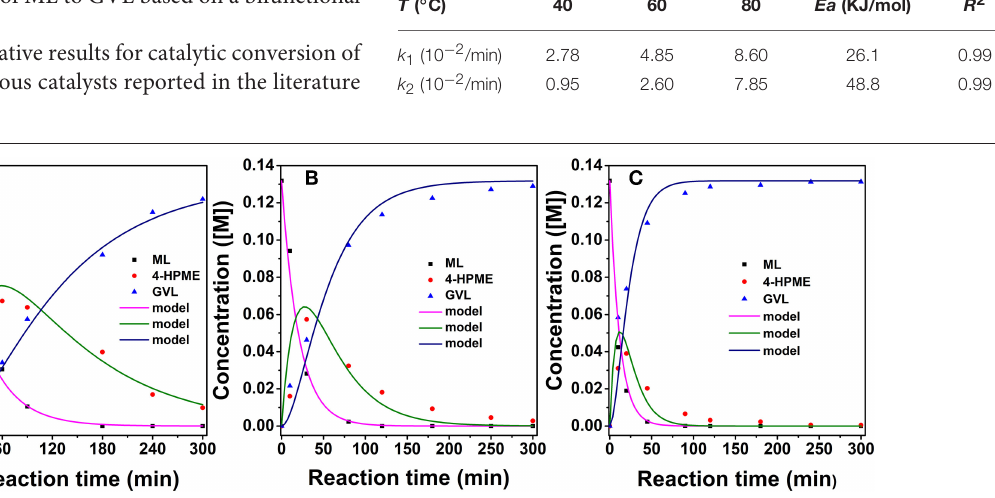
FIGURE 9 | Experimental data fitting at 40 ◦ C (A) , 60 ◦ C (B) , and 80 ◦ C (C) for 2.0% Ru/11.7% SiW@UiO − 66. Reaction conditions: 0.257g of ML, 50mg of catalyst, 15mL of H 2 O, and an H 2 pressure of 2.0